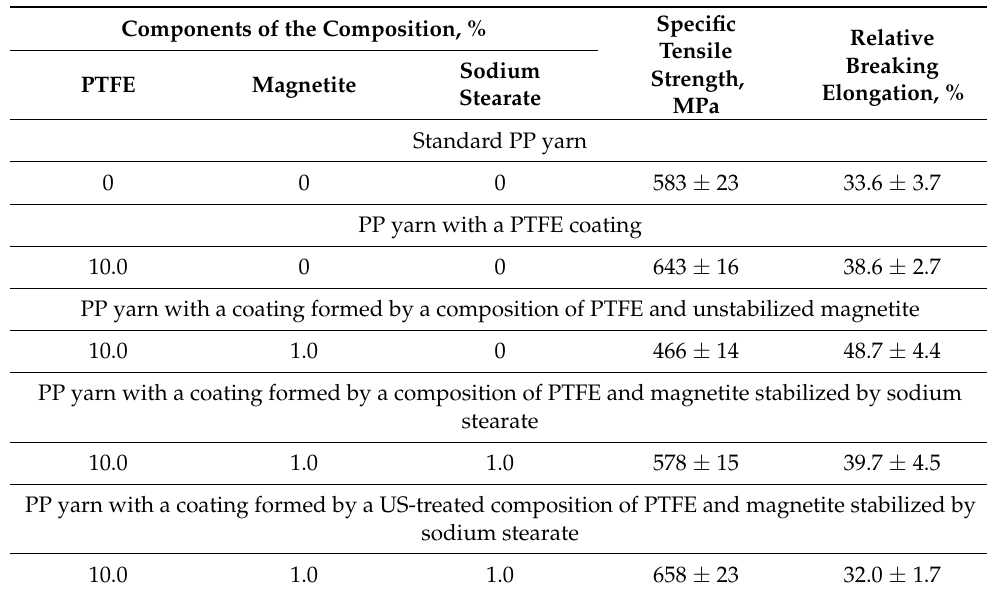
Figure 3. Size distribution after US treatment of magnetite particles synthesized using sodium stearate as the stabilizer.